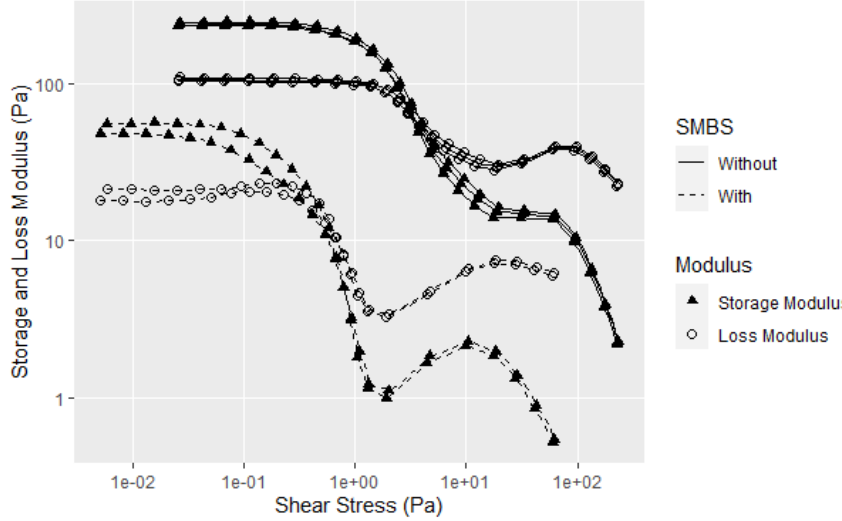
Figure A9. All replicates for samples shown in Figure 10.